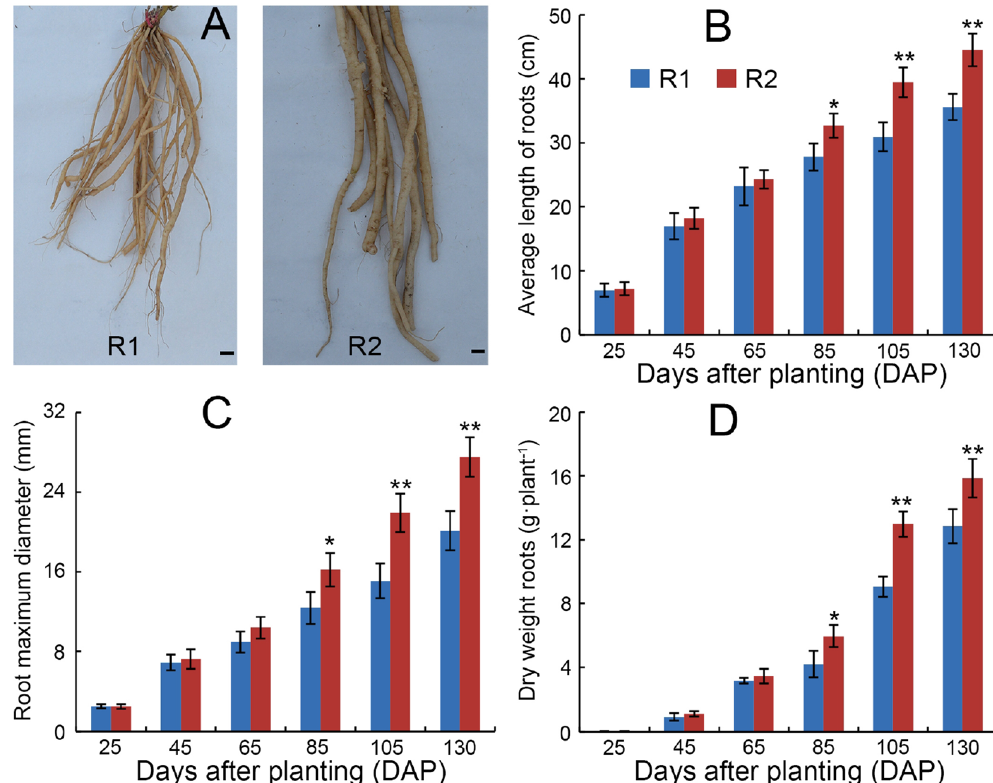
Figure 1. The morphological characteristics from R1 and R2 roots. ( A ) The root photograph at the 130 DAP (bar = 2 cm), ( B , C ) root morphological index and ( D ) biomass. The bars represent the standard error ( n = 3); “*” and “**” represent different significance P < 0.05 and 0.01, respectively. The same